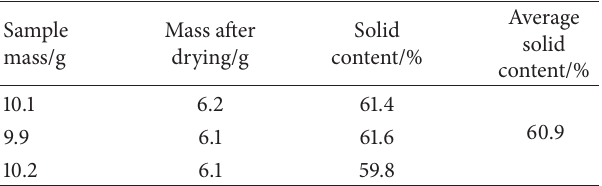
Table 12: Measured results of the solid content of the accelerator. Sample Mass after Solid mass/g drying/g content/%